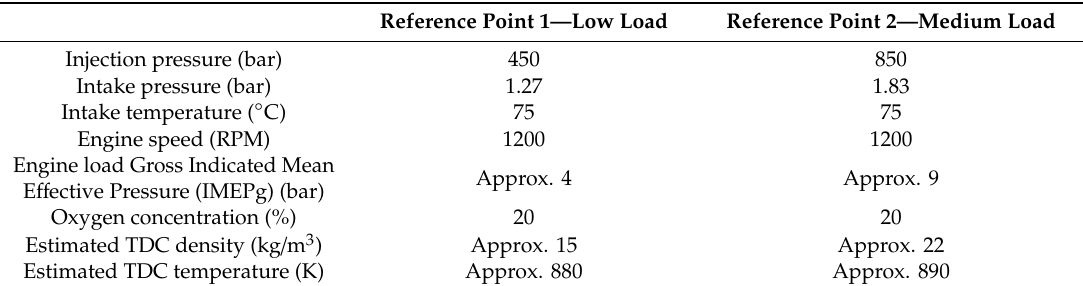
Table 2. Operating points and their estimated top dead center (TDC) conditions.